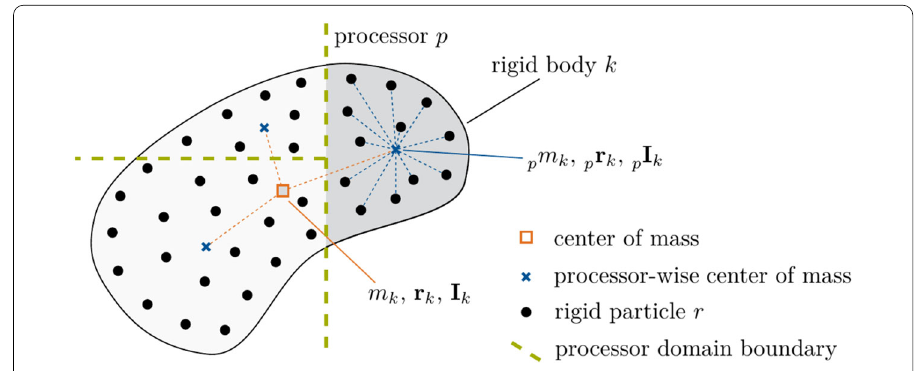
Fig. 4 Parallel distribution of a rigid body k with rigid particles r over several processors p illustrating the evaluation of mass m k , center of mass position r k , and mass moment of inertia I k via processor-wise mass p m k , center of mass position p r k , and mass moment of inertia p I